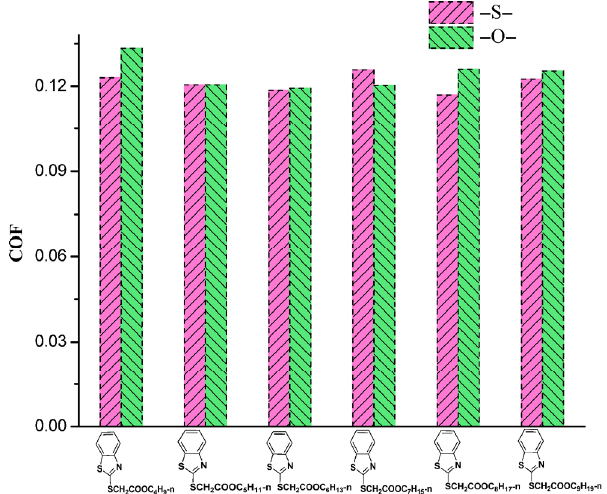
Fig. 21 The wear scar width of each steel ball when lubricating with 2-benzothiazole-S-carboxylic acid esters and their isosteres in triisodecyl trimellitate.